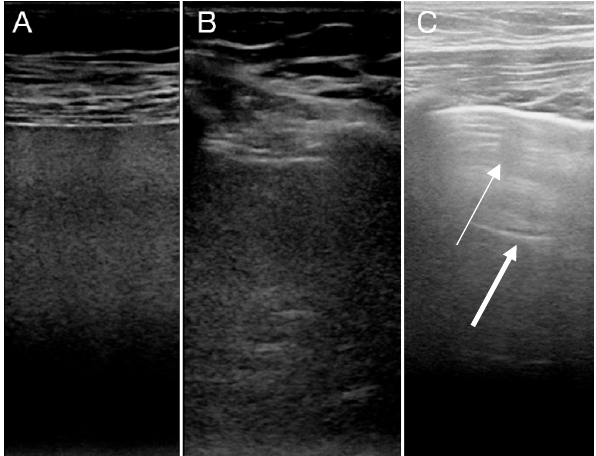
Figure 3. Large consolidations with hepatization in ( A ) and ( B ). Note the absence of A- and B-lines. In ( C ), LUS of a normal lung segment is shown with focal B-lines and A-lines present (thin arrow points to B-Lines and the bold arrow to A-line).